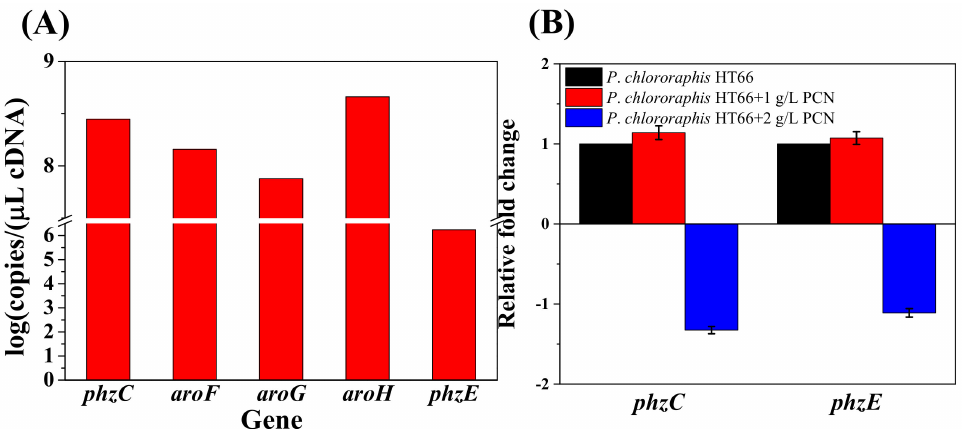
Figure 6. Transcriptional level of different DAHP synthase genes and inhibition of PCN on phzC and phzE transcription. ( A ) Based on absolute quantification; ( B ) Based on relative quantification. Calculation of the copy numbers of target gene was shown in Table S4 in Supplementary